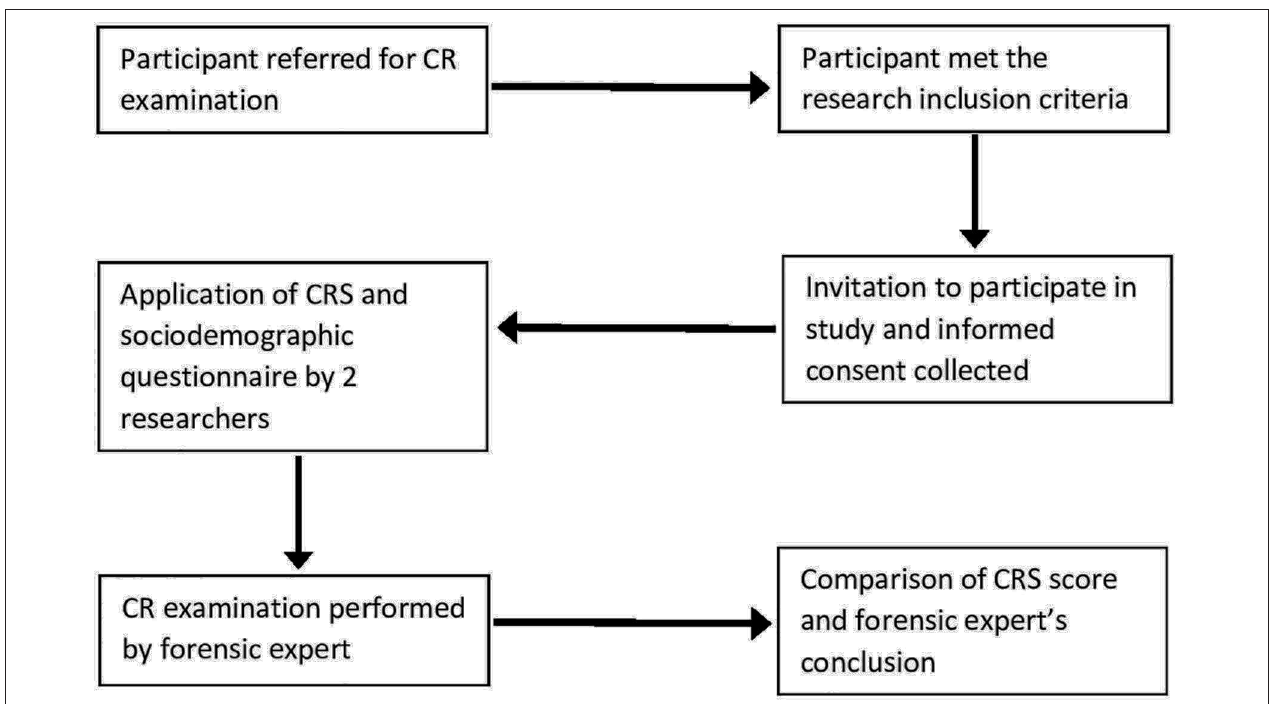
FIGURE 1 | Flowchart for application of the CRS to participants and comparison with forensic expert’s conclusion. CR, criminal responsibility; CRS, Criminal responsibility